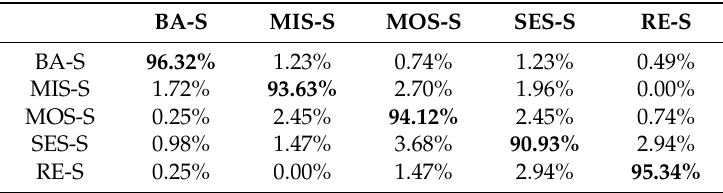
Table 4. Classification rates of K-ELM with SC features (SC + K-ELM).